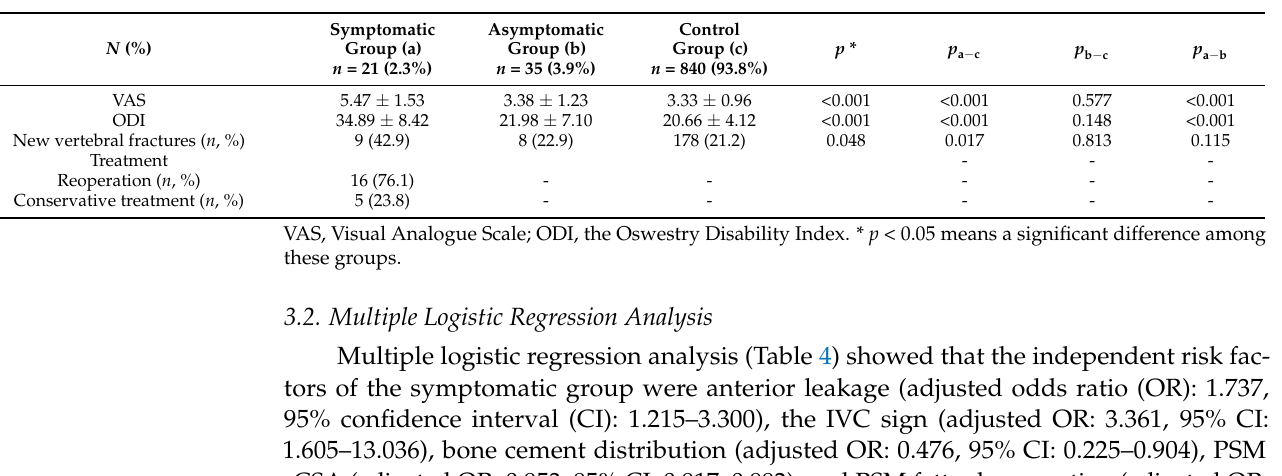
Table 3. Intergroup comparison of patients’ outcomes.